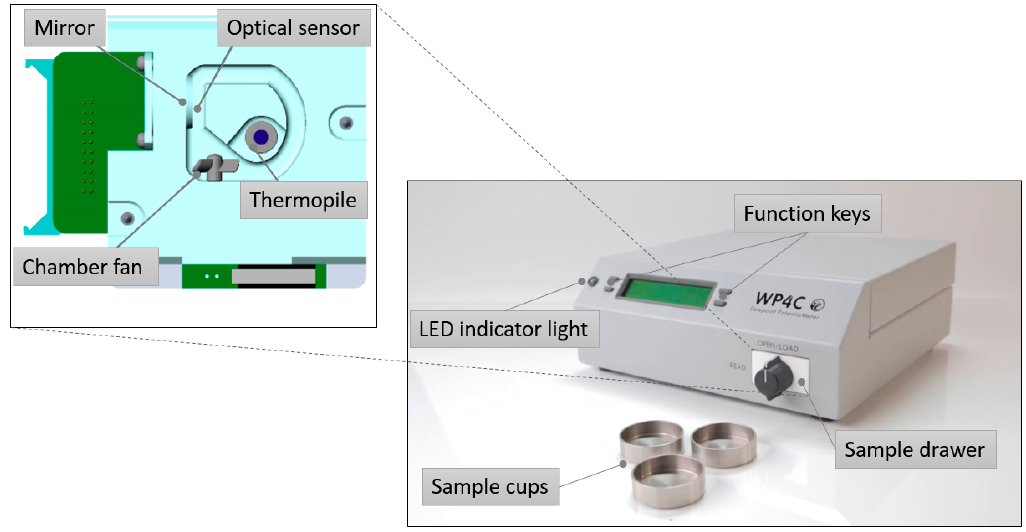
Figure 2. WP4C components: Views of the front and inside of the soil chamber block adapted from WP4C Dew Point PotentioMeter Operator’s Manual [51].